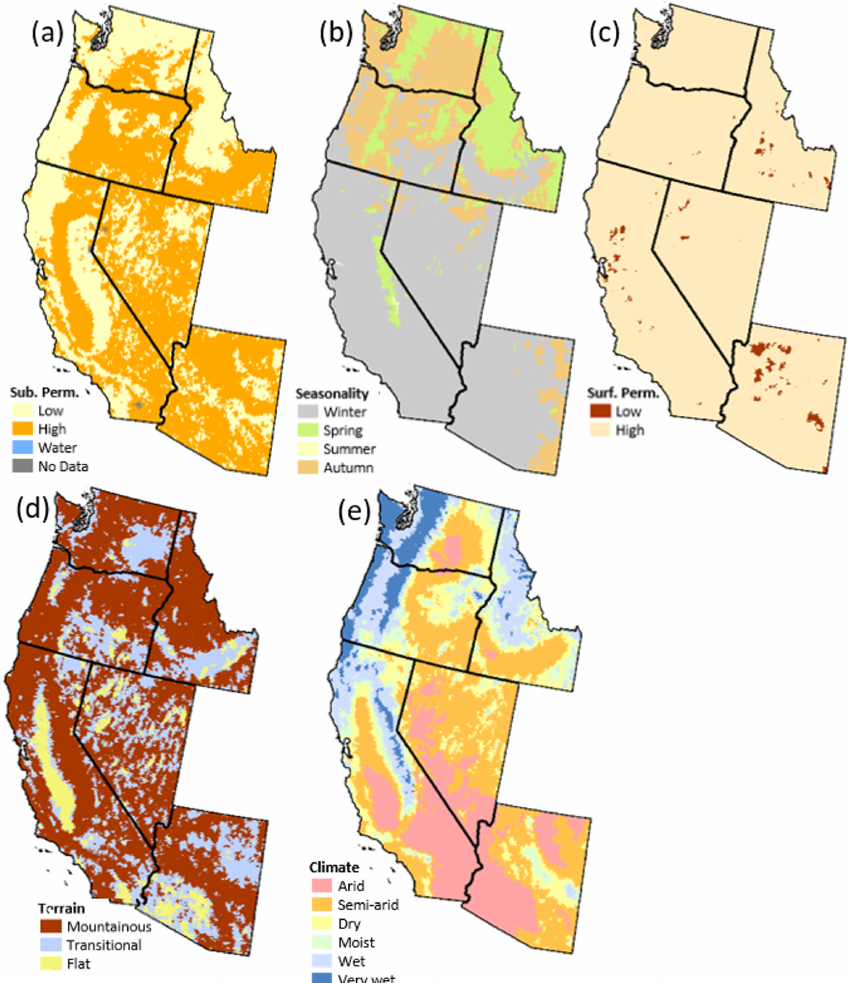
Figure A1. Component hydrologic landscape maps of Washington, Idaho, Oregon, California, Nevada, and Arizona were used in the analysis of the HLVA indices: (a) subsurface permeability, (b) seasonality of precipitation surplus, (c) surface permeability, (d) climate, and (e) terrain. Notes: the seasonality map for the PNW has been updated from the original Leibowitz et al. (2016) HL map, as we separated their winter seasonality into two seasons (winter and